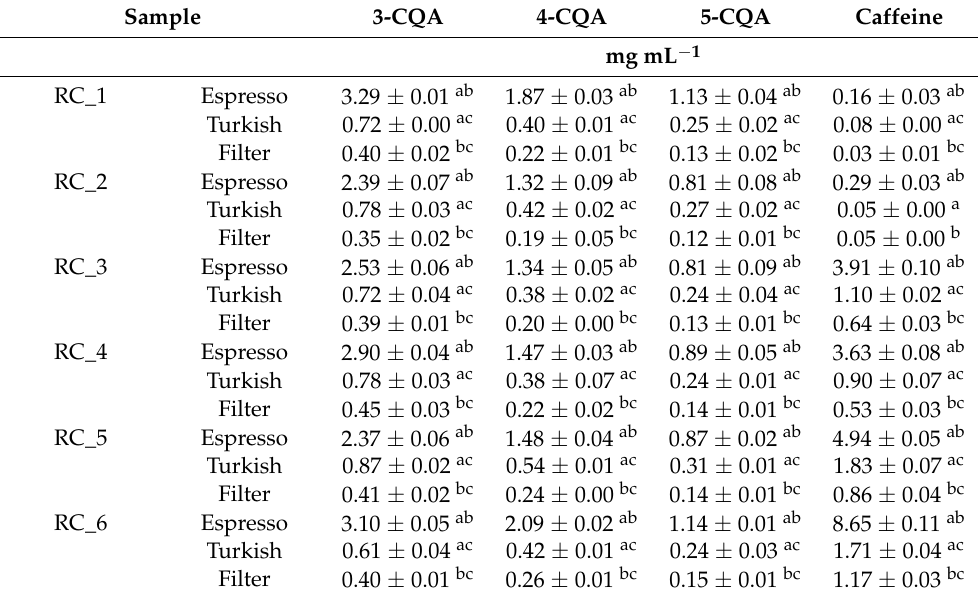
Table 6. Content of 3-CQA, 4-CQA, 5-CQA and caffeine in differently prepared coffee